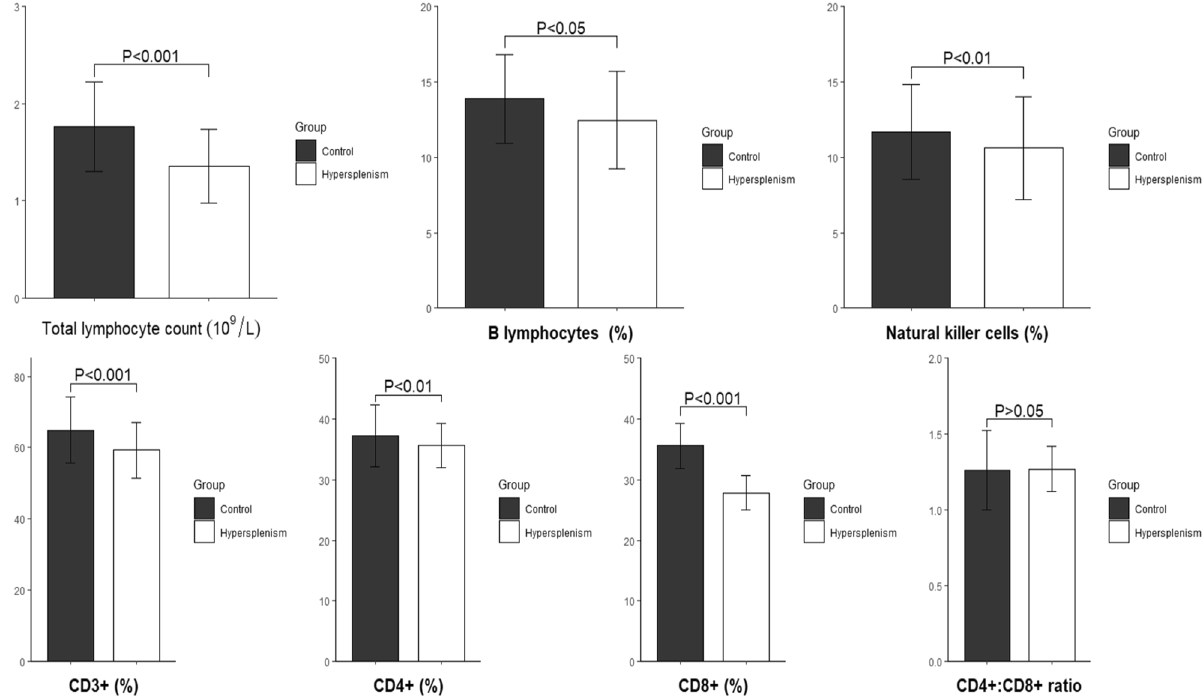
Figure 1. Comparison of peripheral lymphocytes and their subsets between the hypersplenism group and control